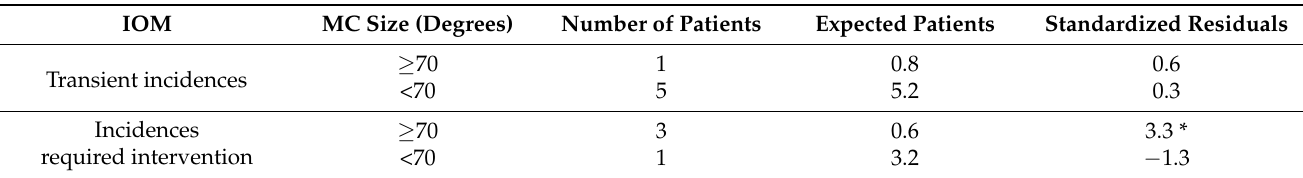
Table 2. IOM results.